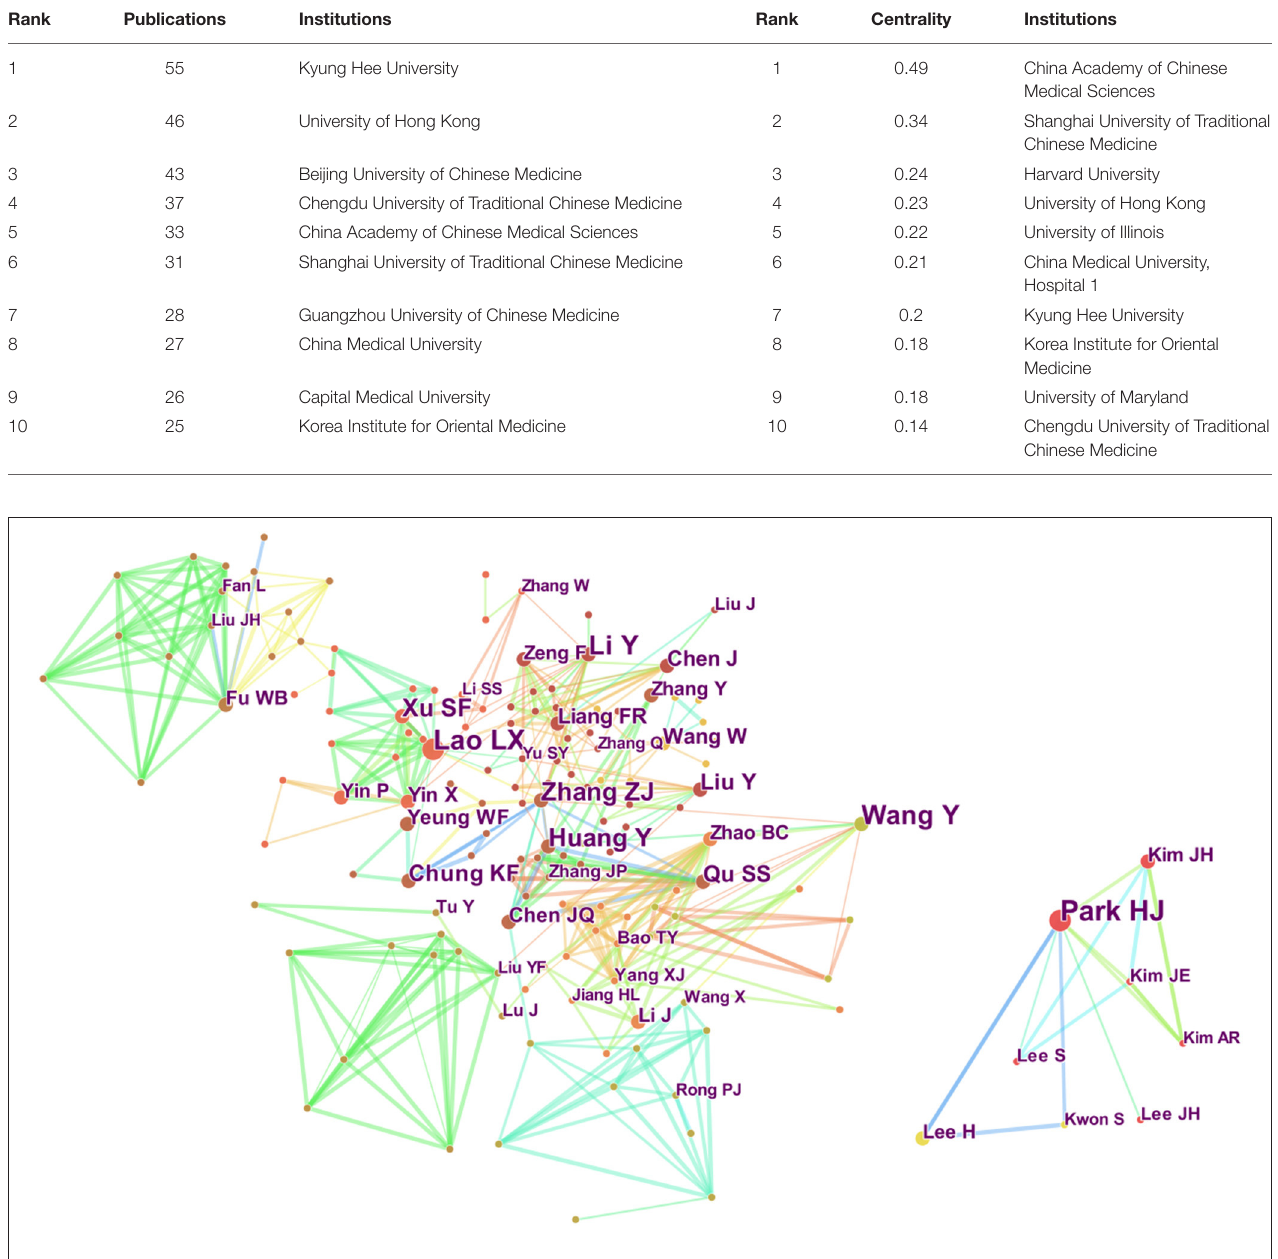
FIGURE 5 | Map of co-authors related to acupuncture for depression from 2011 to